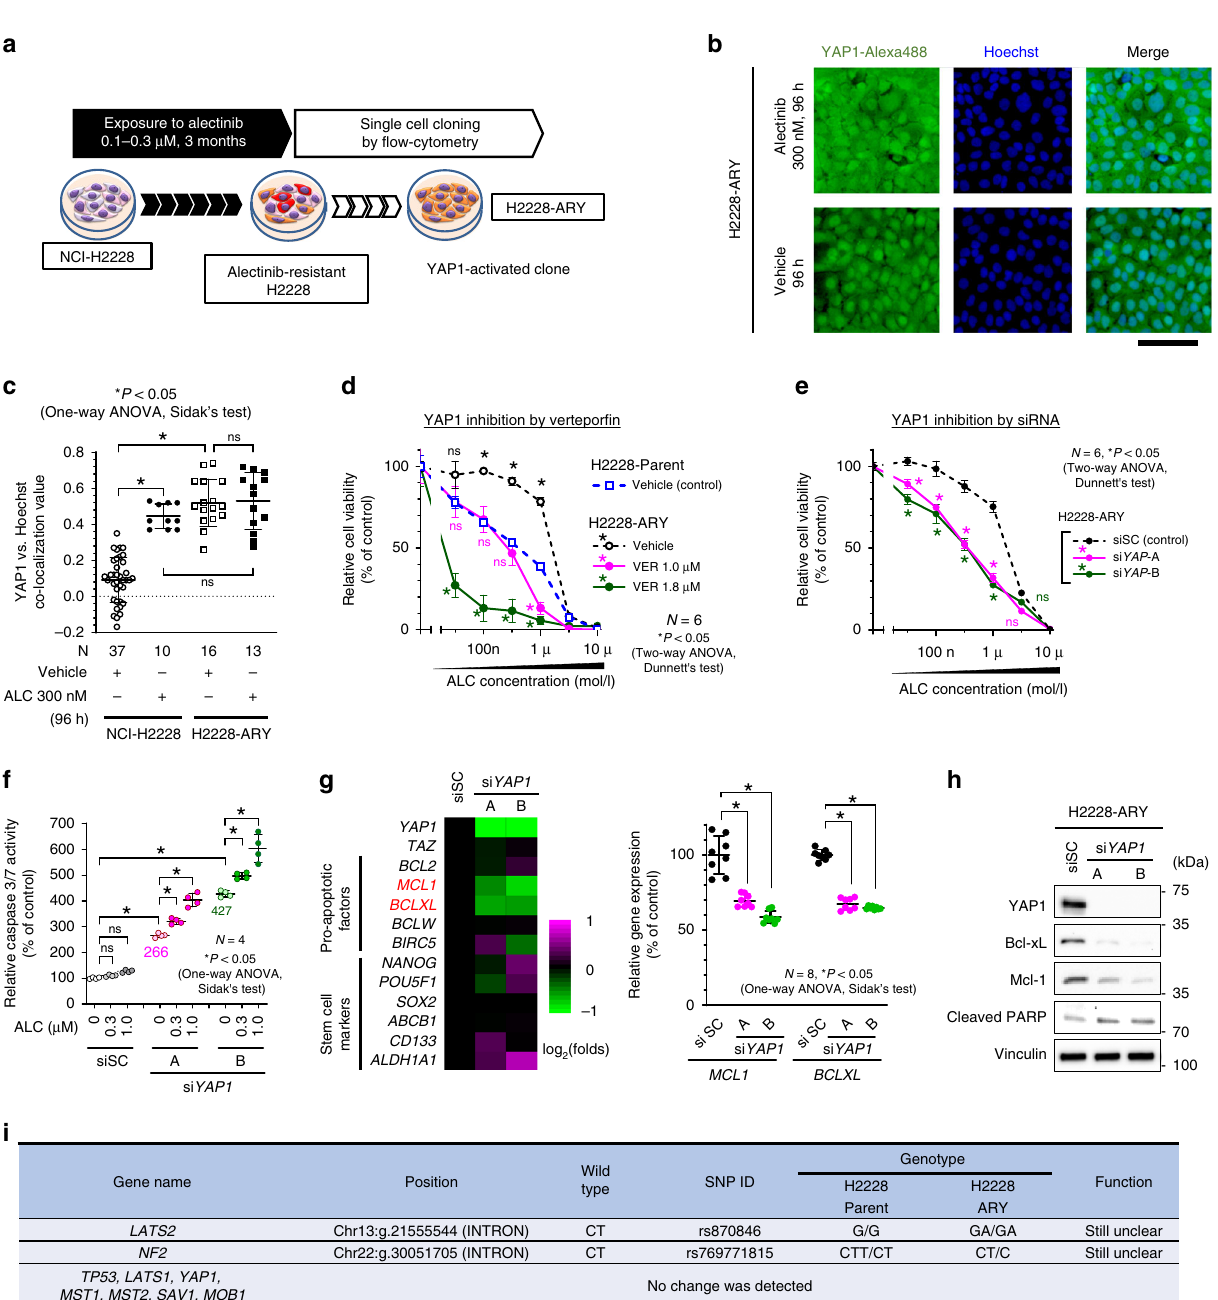
Fig. 5 Screening for effectors of YAP1 for survival of an ALC-resistant cell line. a Schematic explanation for the establishment of H2228-ARY. This YAP1- activated cell line was established by exposing NCI-H2228 cells to ALC for 3 months and subsequent cell cloning. b Representative images of H2228-ARY with a 96-h exposure to either ALC or vehicle. Fixed cells were stained by YAP1-alexa488 and Hoechst. Scale bar = 100 µ m. c Quanti fi ed nuclear localization of YAP1 in H2228 or H2228-ARY cells. The number of images analyzed is presented in the fi gure. Signi fi cance was evaluated with a one-way ANOVA followed by Sidak ’ s test. d A cell viability assay when H2228 parent and H2228-ARY cells were exposed to stepwise concentrations of ALC for 96 h. Signi fi cance was evaluated using a two-way ANOVA followed by Dunnett ’ s test comparing viability with that of H2228 parent cells. e A cell viability assay when H2228-ARY cells were treated with ALC under the genetic inhibition of YAP1 . Signi fi cance was evaluated using a two-way ANOVA followed by Dunnett ’ s test comparing viability with that of siNC-treated cells. f An apoptosis assay on H2228-ARY cells treated with ALC under si YAP1 . Signi fi cance was evaluated using a one-way ANOVA followed by Sidak ’ s test. g Screening of effectors for YAP1 that induced apoptosis using qRT-PCR. Heatmap of the 13 factors (left, n = 4 independent experiments) and detected individual values of MCL1 and BCLXL gene expression (right, n = 8 independent experiments). The individual values of other genes were plotted in Supplementary Fig. 5a. Color scale shows the change of each gene expression: magenta and green means increased and decreased expression, respectively. Signi fi cance was evaluated using a one-way ANOVA followed by Sidak ’ s test. h The knockdown of YAP1 inhibited the protein expression of MCL1 and BCLXL in H2228-ARY cells. i Summary of exome sequencing that compared the sequences of presented genes between H2228 cells and H2228-ARY cells. The full results are shown in Supplementary Data 3. The exome sequence can identify some parts of the intron sequence that are near the exons. ALC alectinib, VER:vertepor fi n, siSC si scramble control. Error bars indicate ± S.D. * P <